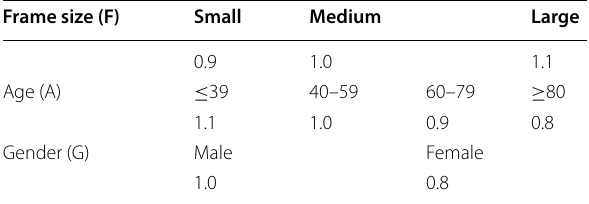
Table 2 Coefficients used to determine an ICU patients daily caloric goal in Christchurch ICU